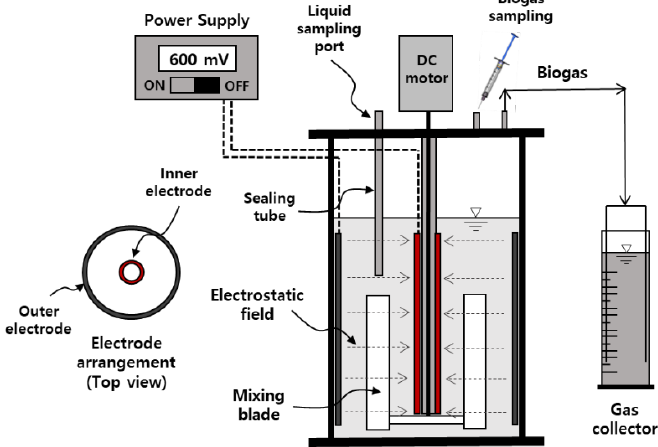
Figure 1. Schematic of the bioelectrochemical nitrogen removal reactor exposed to an electrostatic field.